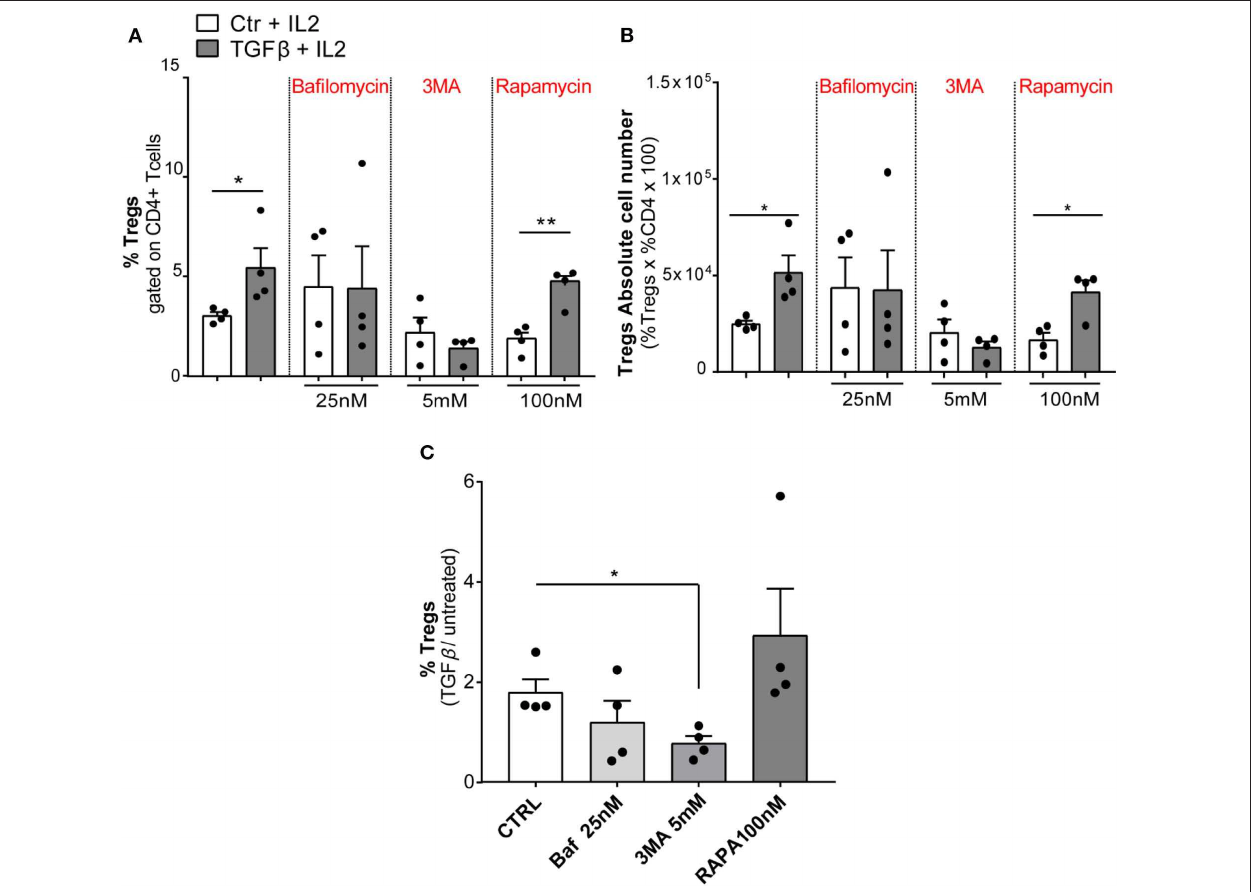
FIGURE 6 | Modulation of autophagic flux during regulatory T-cell (Treg) differentiation. Tregs were induced by culturing naïve CD4 + T cells isolated from wt mice ( n = 4, two mice per experiment) in the presence of IL2 (100 U/ml), treated or not with TGF β (2ng/ml) and stimulated with plate-bound anti-CD3 and anti-CD28 for 24h. The histograms show the frequency of Tregs (A) , absolute number of Tregs (B) , and the result represented as normalization TGF β /untreated (C) . The experiment was performed with autophagy modulators: bafilomycin (25nM), 3-methyladenine (3MA, 5mM), and rapamycin (100nM) for 24h. * P < 0.05, ** P < 0.01, by unpaired t -test,